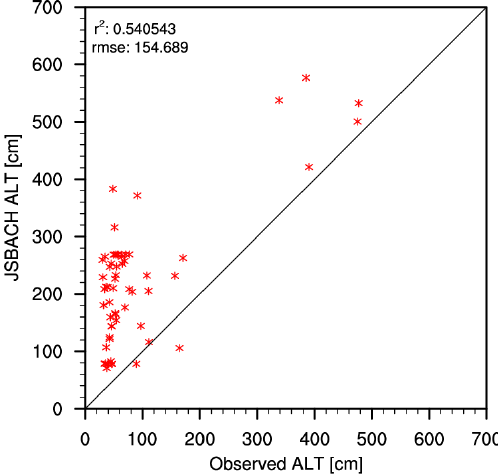
Fig. 9. Scatter plot of the observed ALT from the CALM network (Brown et al., 2000) versus the JSBACH results. See text for further